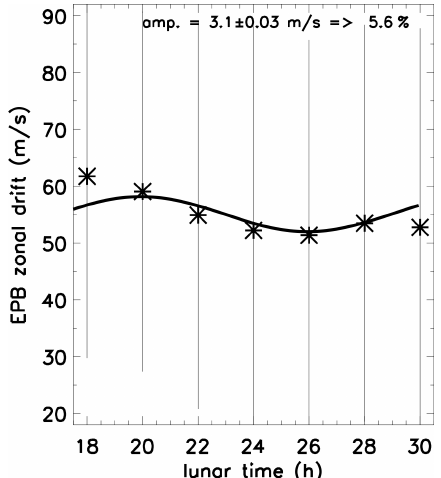
Figure 1. EPB zonal drift (stars) obtained from airglow images and semidiurnal lunar tide fits (solid line) as a function of lunar time for the whole observed period. Error bars represent the standard devia- tion at each hourly bin. The estimated amplitude of a 12 oscillation is shown on the top with its uncertainty.